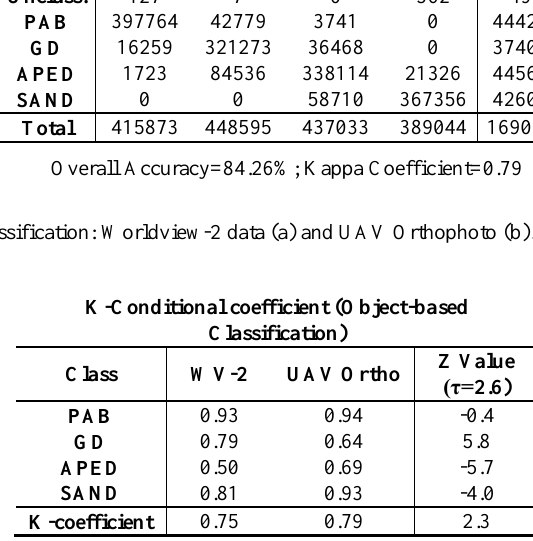
Table 6. K-Comparison between the WV-2 pixel